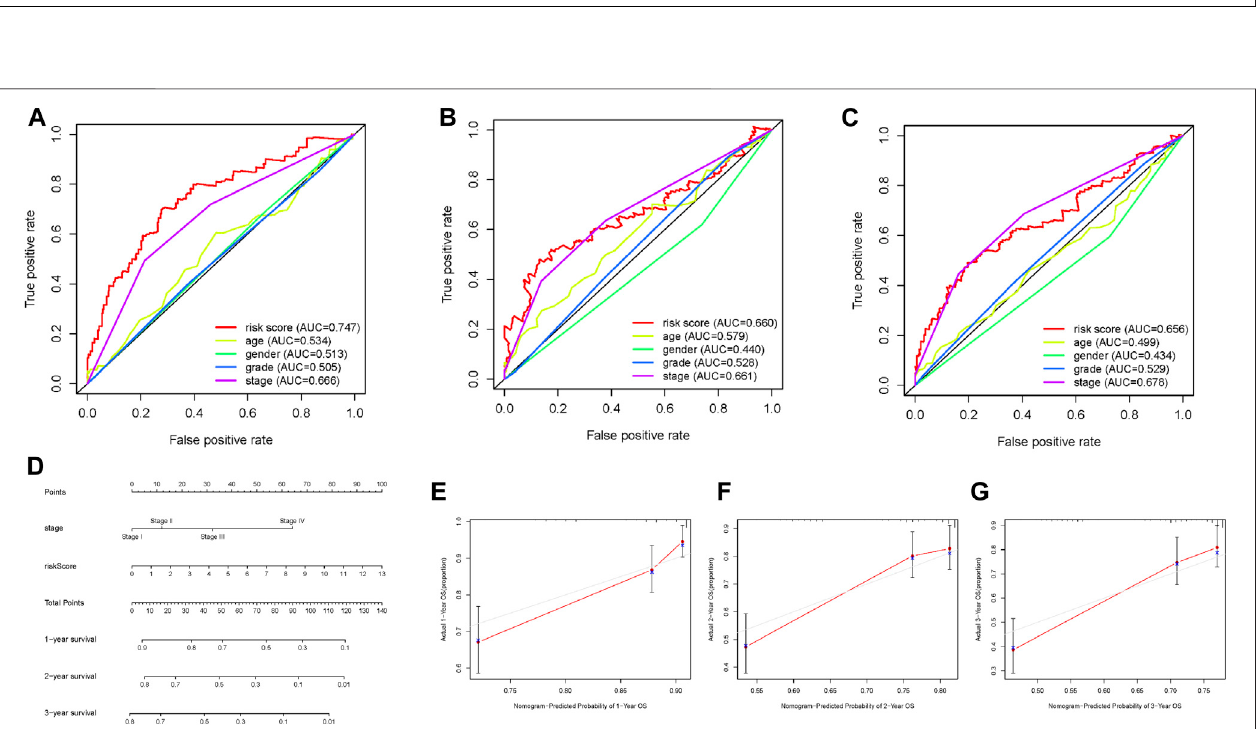
FIGURE5| Screeningprognosticindicatorsandnomogram. (A – C) ROCcurveof1-,2-,and3-yearOSformultipleprognosticindicatorsofHCCsamples. (D) The nomogram was drawn using tumor grade and risk score. (E) One-year nomogram calibration curves of entire TCGA cohort. (F) Two-year nomogram calibration curves of entire TCGA cohort. (G) Three-year nomogram calibration curves of entire TCGA cohort.